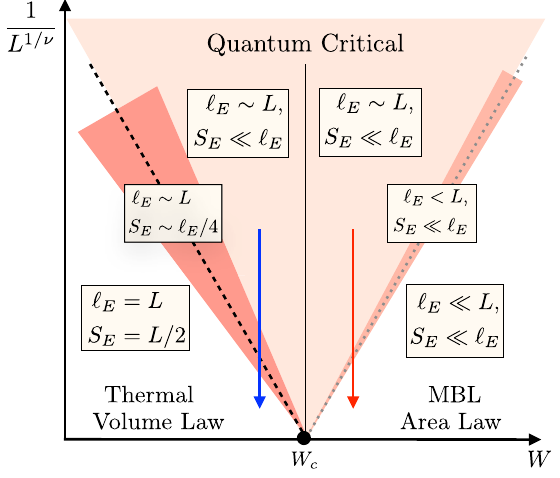
FIG. 7. Schematic illustration of our “ picture ” of the MBL phase transition showing the physical extent and entanglement properties of the typical longest entangled cluster in the different